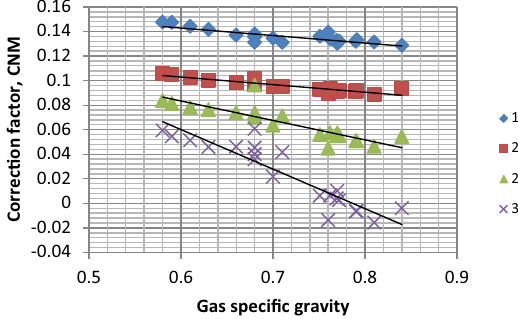
Fig. 6 Calculation of C NM at 200 (cid:3) F and different pressures